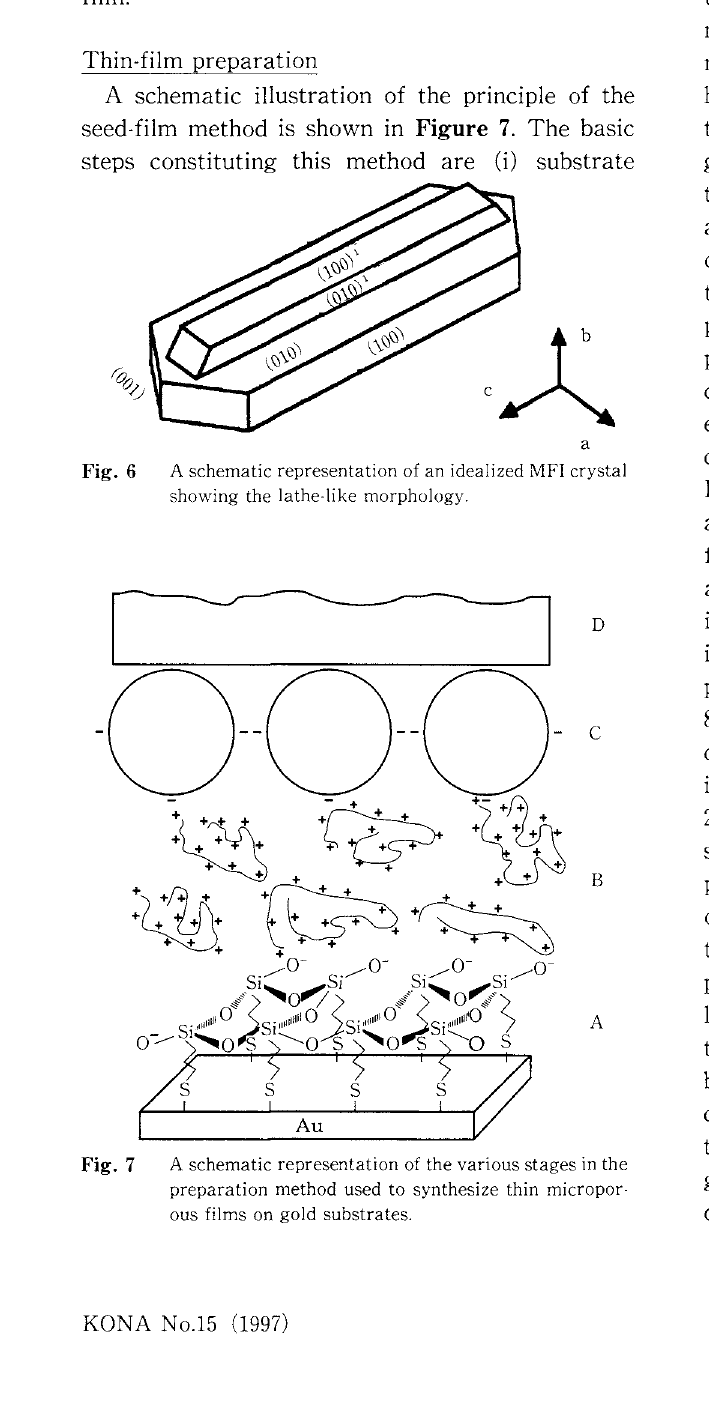
A schematic representation of an idealized MFI crystal showing the lathe-like morphology.